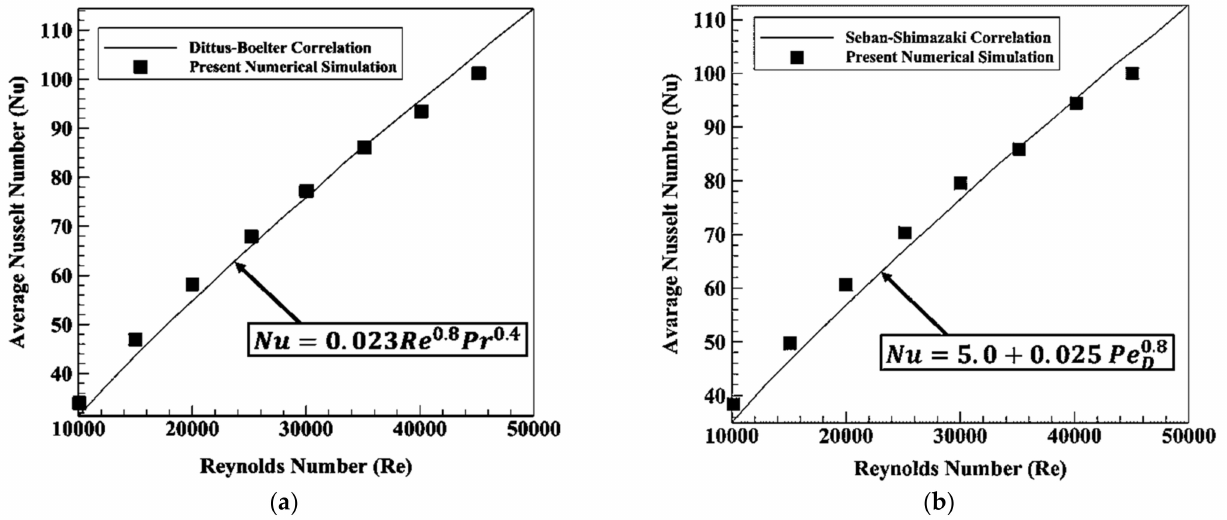
Figure 5. Validation betwixt the available simulation and ( a ) Dittus–Boelter correlation [41]; ( b ) Seban–Shimazaki correla- tion [59].